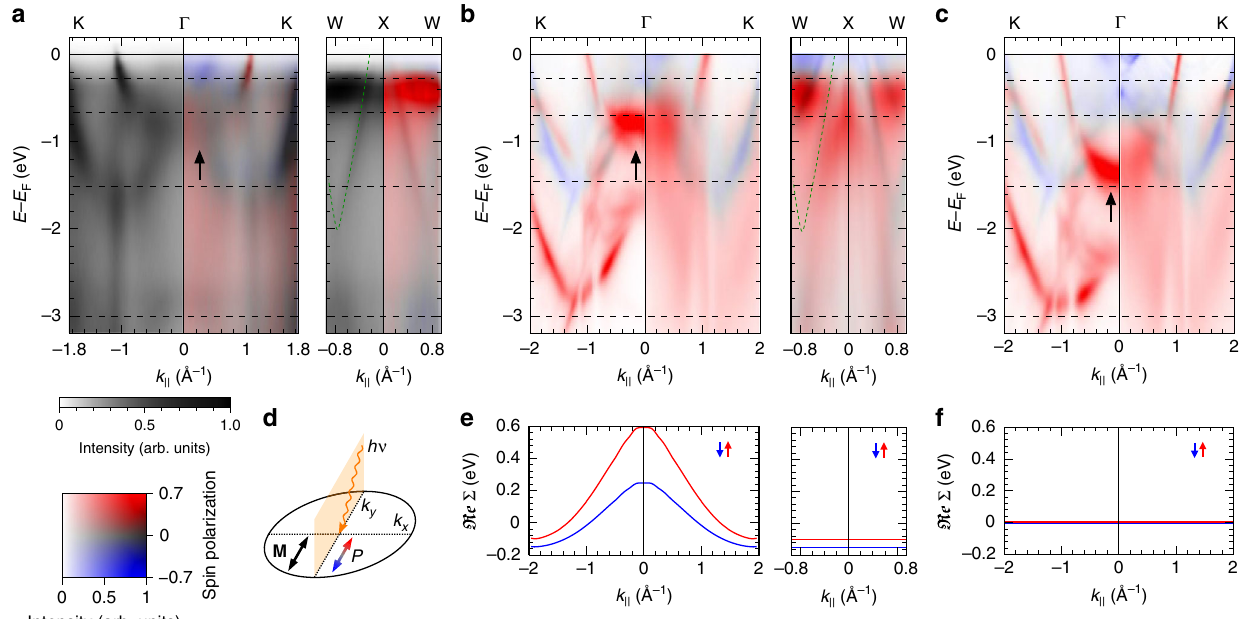
Fig. 2 Spin-resolved band dispersion maps. a Dispersion of cobalt bands along the K- Γ -K and W-X-W directions as function of binding energy ( E - E F ), measured at hv = 50 eV. The left half in a shows the spin-averaging experiment on a grey intensity scale, and the right half the spin-resolved experiment in the same 2D colour code as in Fig. 1. Dashed horizontal lines indicate energies of 2D momentum maps in Fig. 4. b Calculated spin-resolved photoemission intensities corresponding to a using momentum-dependent corrections for the band renormalization Re Σ σ ( k ) as in e , and constant (left half) or E - dependent broadening ℑ m Σ σ ( E ) (right half). Dashed curves indicate faint band positions as guide to the eye. c Calculation using a constant Re Σ for as in f . The bottom of the majority electron parabola (see solid arrows) lies too deep, compared with the experiment in a and calculation in b . The right half of panel c uses an energy depended ℑ m Σ σ ( E ) following DMFT calculations from Ref. 11 , which underestimates broadening close to E F . d Photoemission geometry used both, in experiment and theory: The photon beam is incident along the positive k y direction with 25° towards the surface, magnetization M and polarization P are in-plane along k